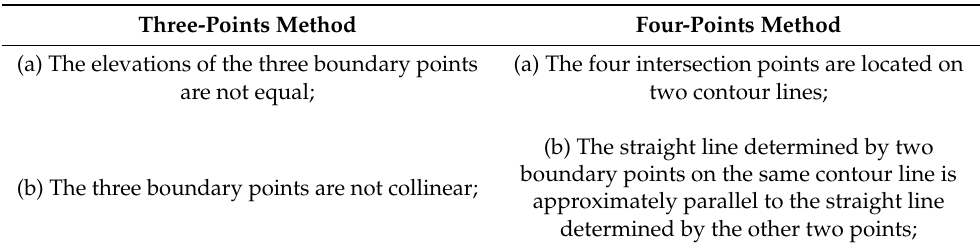
Table 2. Calculation conditions of three-point and four-points methods.